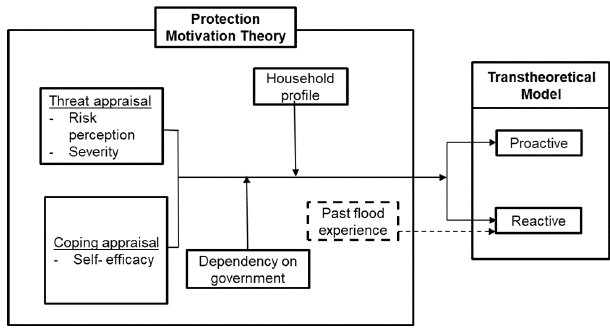
Figure 2. Protection motivation theory and transtheoretical model (PMT–TTM) framework consisting of PMT and TTM blocks. Past flood experience is represented as dashed lines since it differentiates the reactive households from proactive